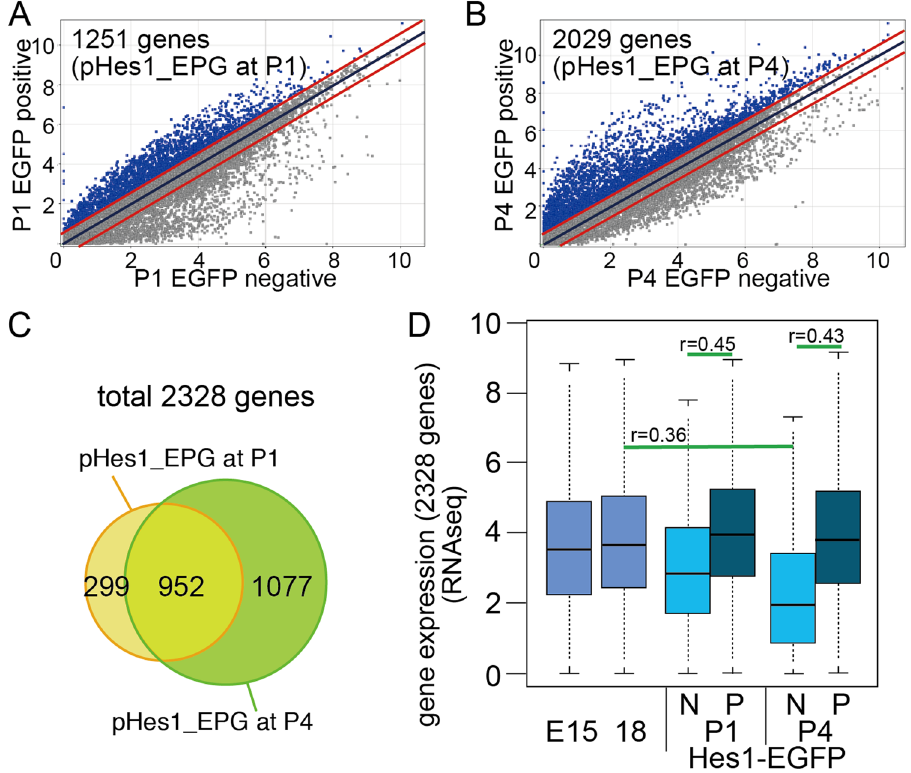
Figure 2. Identification of pHes1-EGFP positive cell specific genes. ( A , B ) Global gene expression levels of EGFP negative (horizontal axis) and EGFP positive (vertical axis) pattern of RNA-seq derived from P1 ( A ) and P4 ( B ) pHes1 -EGFP mouse retina. Diagonal lines indicate median (middle line) and + / − 2 fold difference values (upper and lower lines). Genes predominantly expressed in either fraction was designated as pHes1-EPG and pHes1-ENG only if expressed at > 2 fold than opponent fraction. ( C ) Venn diagram showing overlapping of genes of pHes1-EPG at P1 vs. pHes1-EPG at P4. ( D ) Average and distribution of gene expression levels of 2,328 genes, which expressed in higher in pHes1-EPG at P1 and/or P4. RNA-seq data of whole retina at E15 and E18 13 , and pHes1-EPC and -ENC are shown. N, negative; P, positive. The p values were calculated by student’s T test, and effect size of the results was examined by Pearson’s correlation coefficient